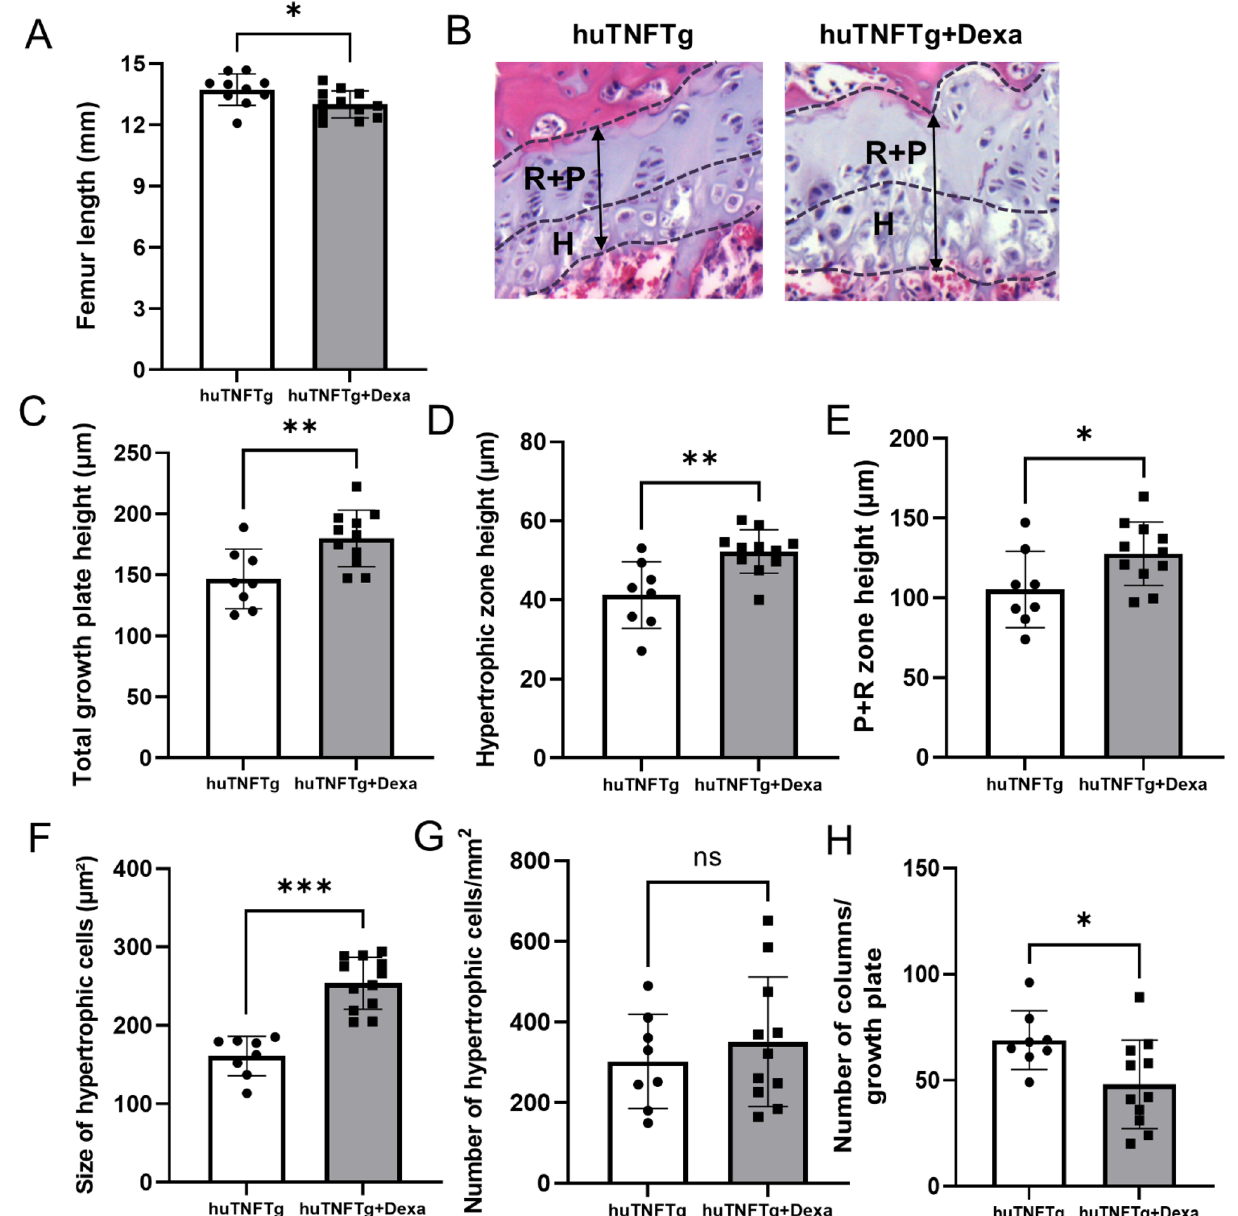
Figure 4. Effects of Dexamethasone (Dexa) treatment on bone growth and chondrogenesis in huTNFTg mice, combined males and females (n = 8–12). ( A ) Femur length measured by digital caliper. ( B ) Representative images indicating different zones and femur growth plate height in each group. ( C ) Measurements of total growth plate height, ( D, E ) the height of the hypertrophic zone and the resting + proliferative (R + P) zone, ( F ) and the mean size of hypertrophic cells in the femur growth plate in each group. ( G, H ) Analysis of the number of hypertrophic cells and the number of columns per growth plate in each group. Error bars indicate mean ± SD. Students t-test was used to analyze difference between groups. * p < 0.05, ** p < 0.01, *** p <